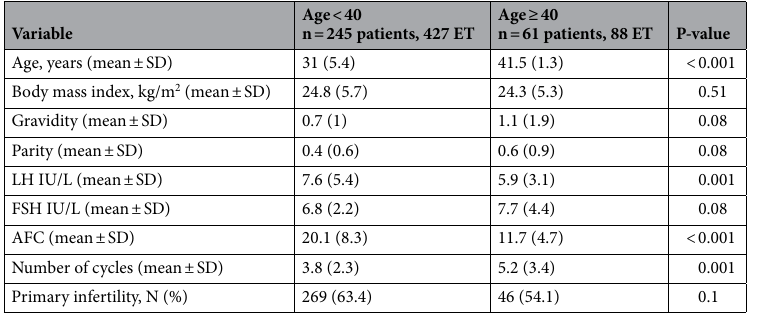
Table 1. Description of the study sample. AFC antral follicle count, FSH follicle stimulating hormone, LH luteinizing hormone.